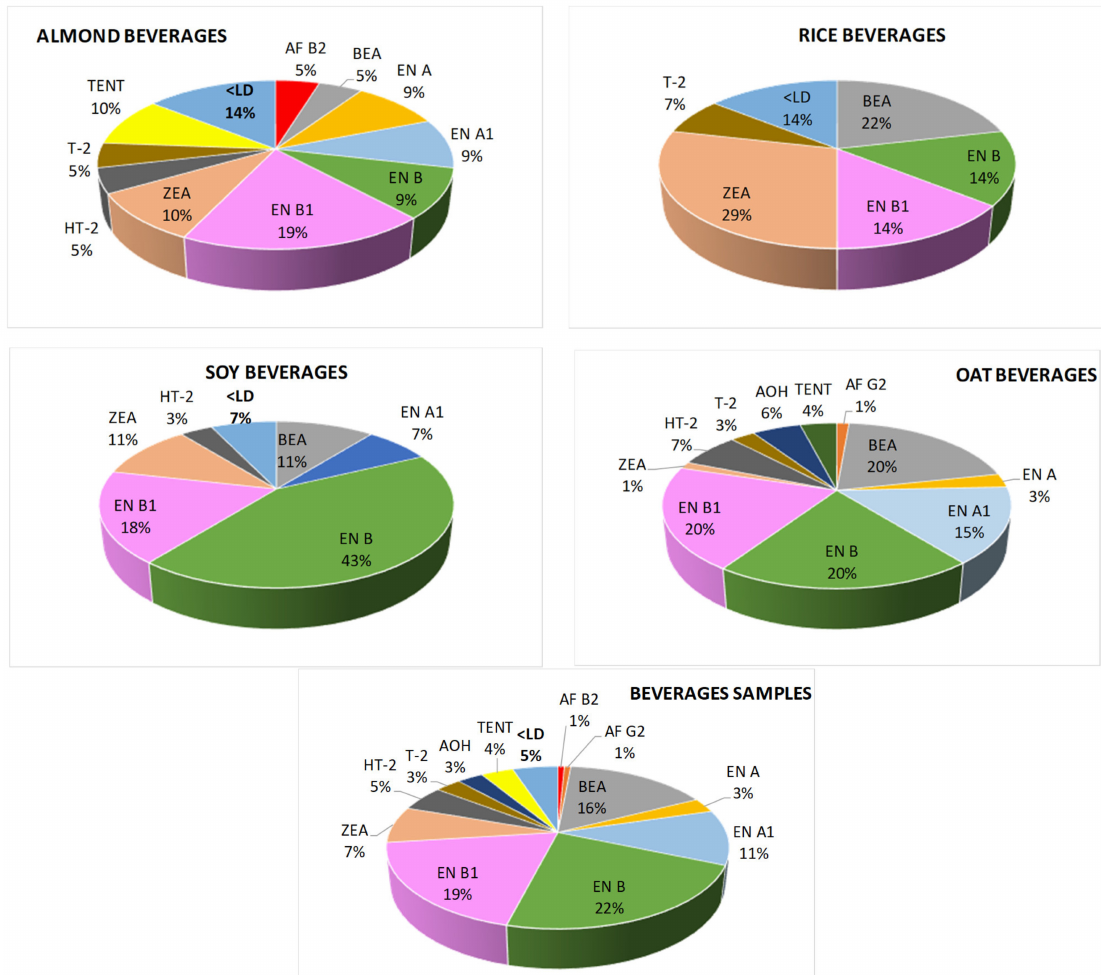
Figure 6. Distribution of the mycotoxins analyzed in the four types of drinks analyzed and in the total samples analyzed (n =